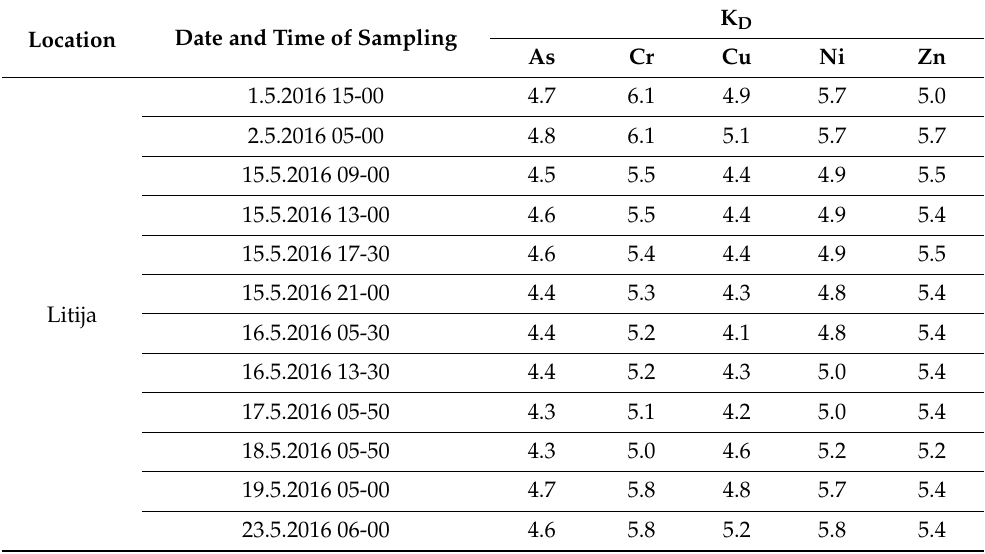
Figure 6. Relationship between the amount of SPM and PTE concentrations in SPE for ( a ) Litija and ( b ) Belgrade, and the relationship between the amount of SPM and AL, Mn and Fe for ( c ) Litija and ( d ) Belgrade. Table 1. Distribution coefficients calculated for Litija and Belgrade